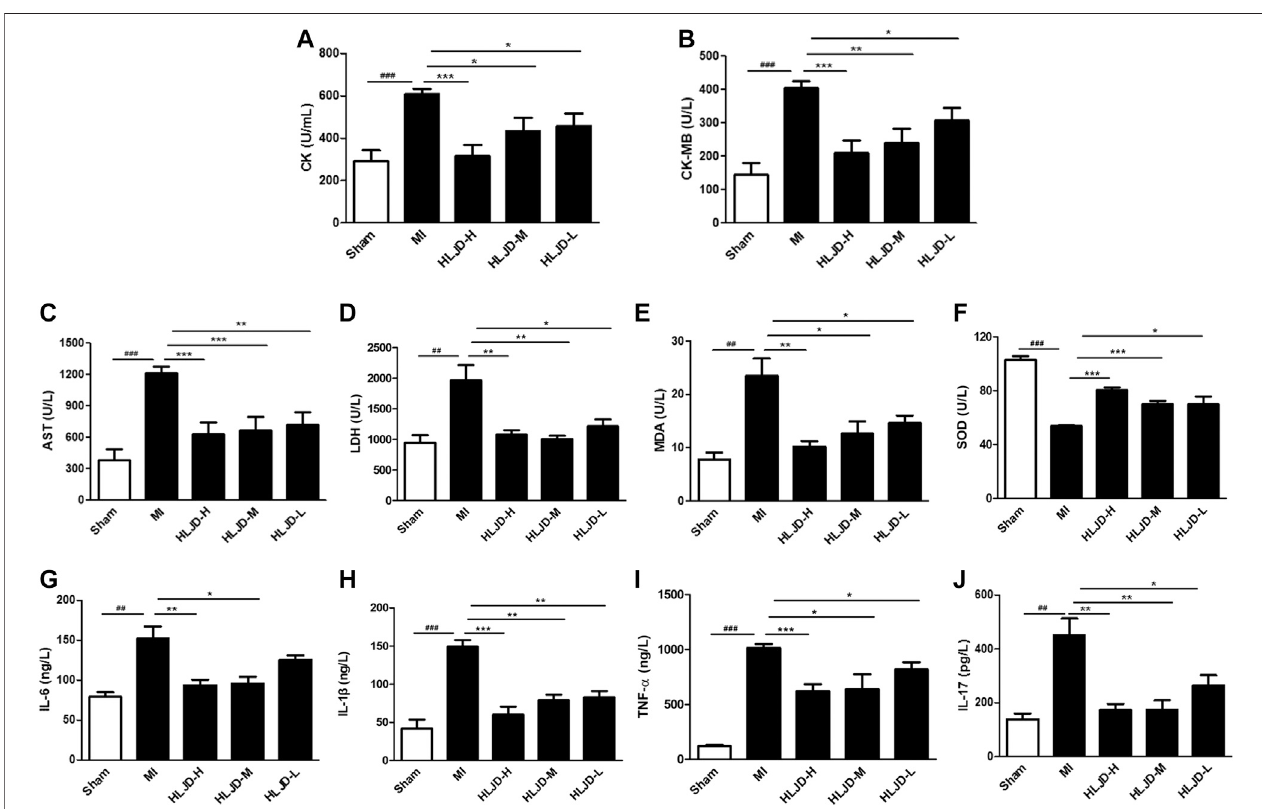
FIGURE 6 | The effect of HLJDT on the release of serum biochemical indicators. (A) Creatine kinase (CK); (B) CK-MB; (C) aspartate aminotransferase (AST); (D) lactate dehydrogenase (LDH); (E) malondialdehyde (MDA); (F) superoxide dismutase (SOD); (G) IL-6; (H) IL-1 β ; (I) TNF- α ; and (J) IL-17 (n (cid:2) 6). Results were presented as mean ± SEM. ## p < 0.01, ### p < 0.001 vs. Sham group; ** p < 0.01, *** p < 0.001 vs. MI